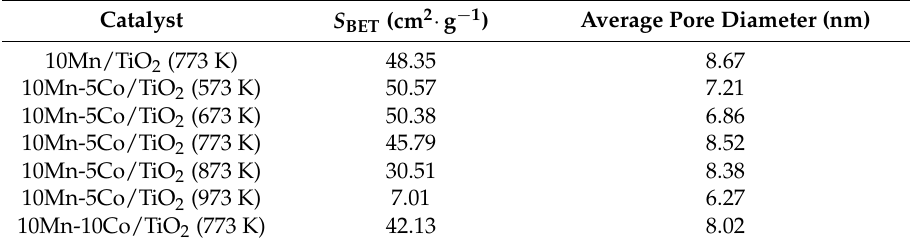
Table 1. BET surface areas and average pore diameters of Mn-Co/TiO 2 catalysts with various Co contents and calcined at different temperatures.